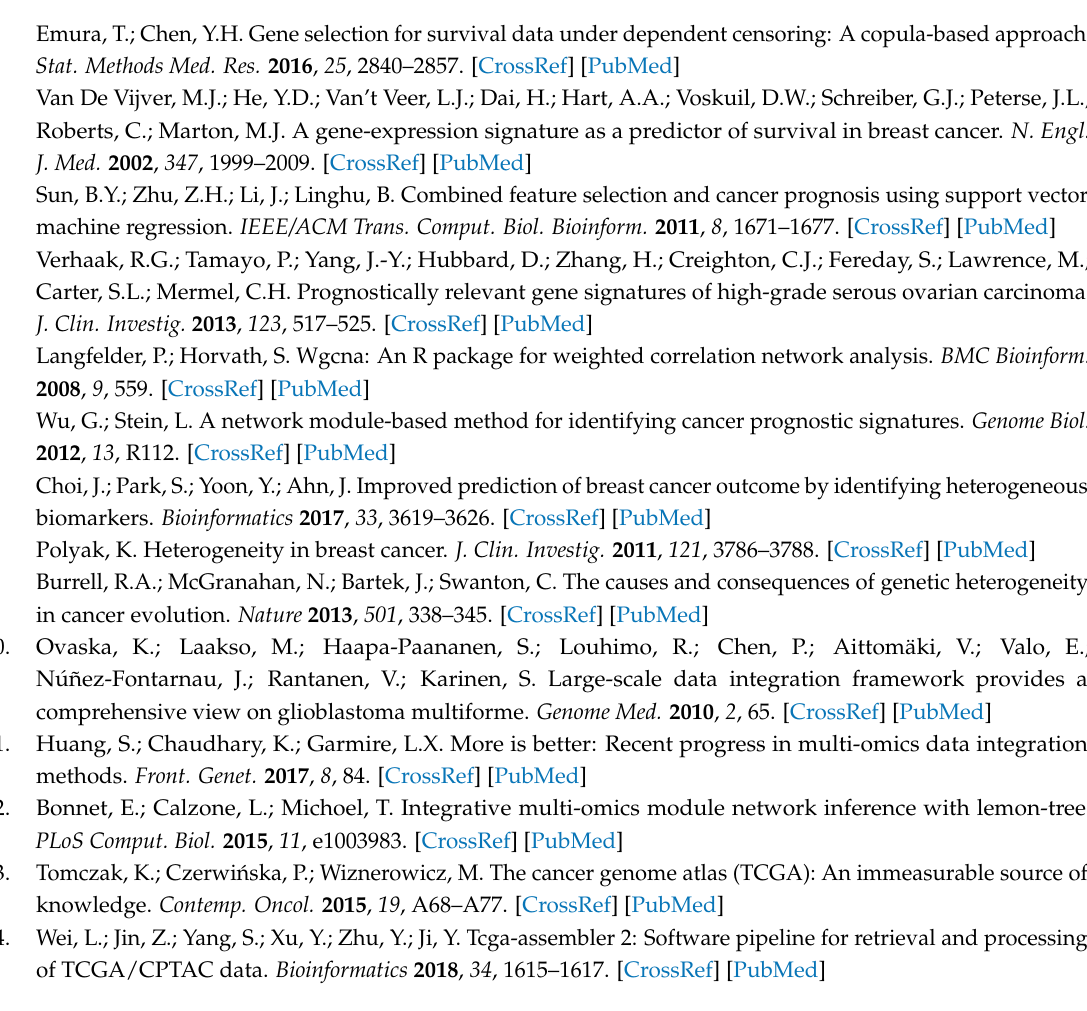
Table S1: Parameter in experiment, Table S2: Biomarkers selected for each cancer type, Table S3: Selected biomarker with only one dataset for PAAD, Table S4: Contingency tables, Table S5: Functional Annotation about biomarker in PAAD using DAVID, Table S6: Functional Annotation about biomarker in BRCA using DAVID, Table S7: Functional Annotation about biomarker in LGG using DAVID, Table S8: Functional Annotation about biomarker in STAD using DAVID, Table S9: Functional Annotation about biomarker in KIRC using